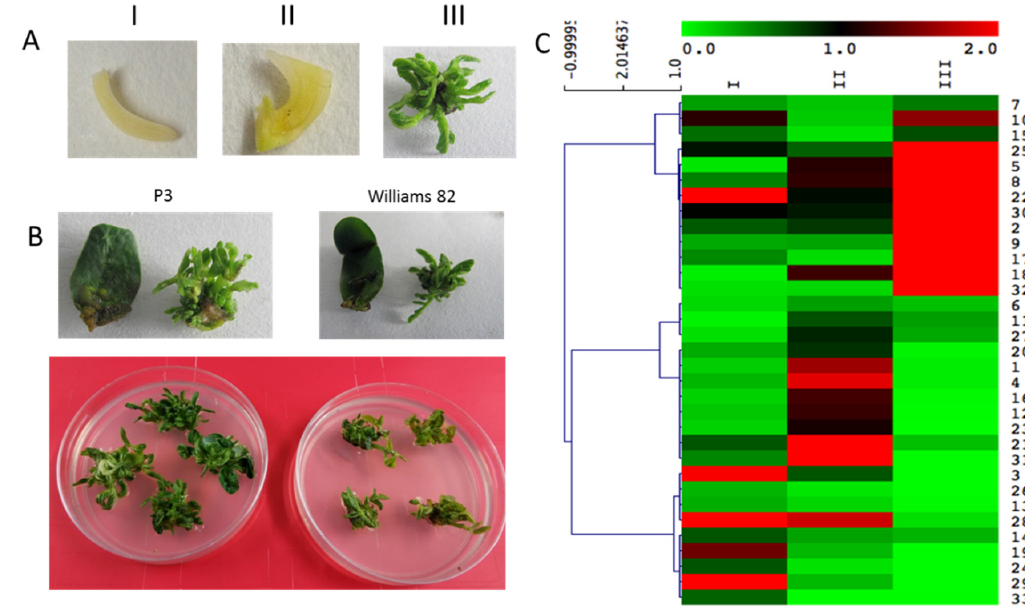
Figure 7. Expression analysis of GmWOX genes in high regeneration capacity soybean material P3. ( A ) Three stages (shoot apical stage, elongated hypocotyl stage, shoot cluster stage) used for sampling; ( B ) Comparison of regeneration ability of two soybean species; ( C ) Expression of GmWOX genes in P3.